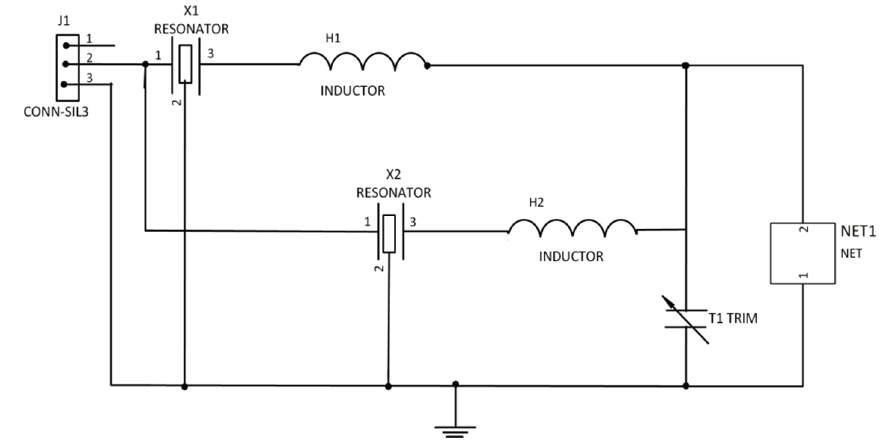
Figure 3. Schematic of DSAWR system with a resistor connected in